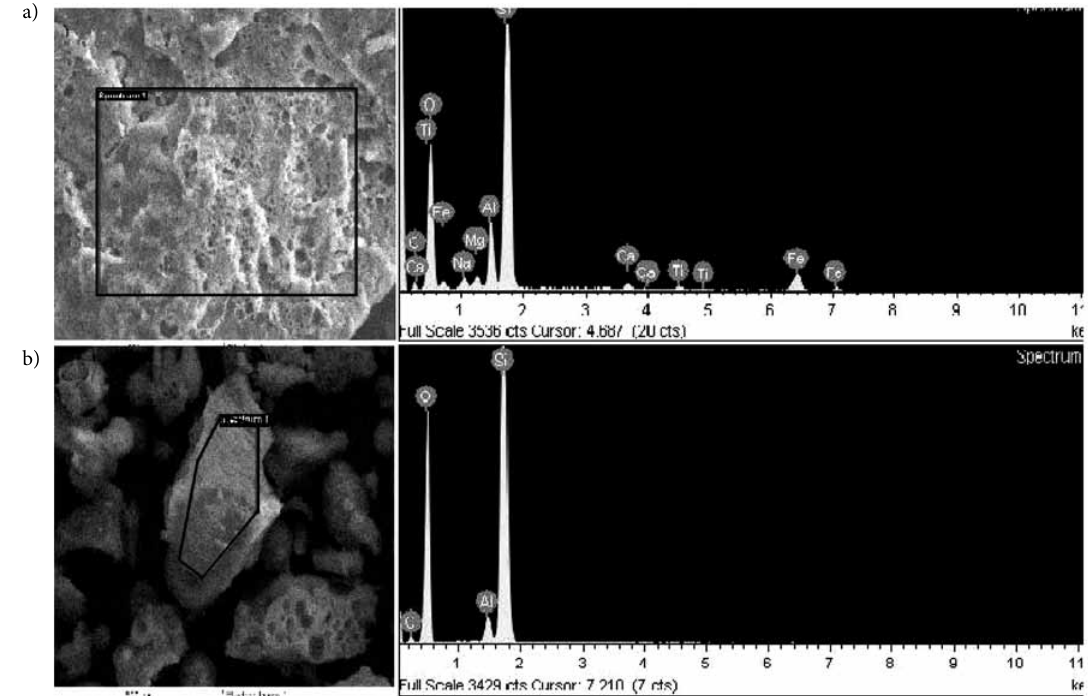
Fig. 9. SEM micrograph and EDS pattern of a) used FA b) used FS, during photo-Fenton treatment of